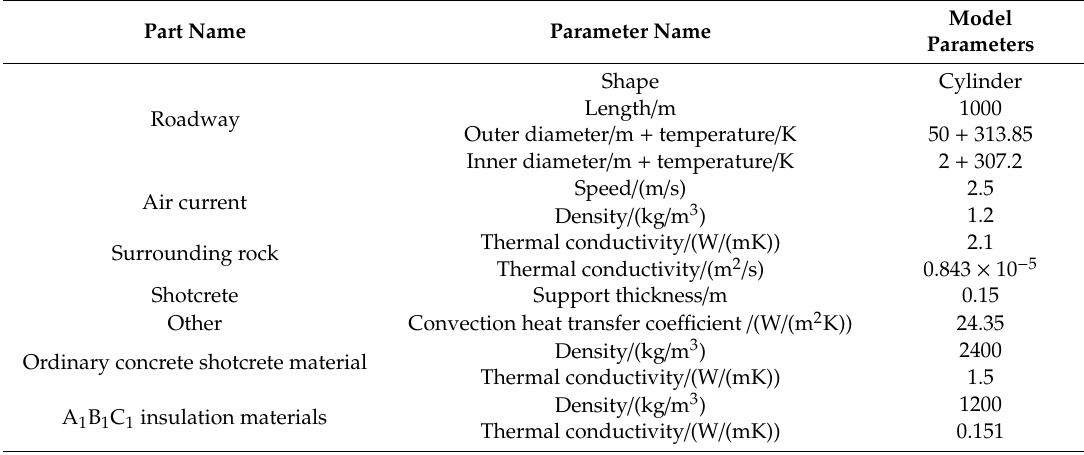
Table 8. Parameters of the simulated